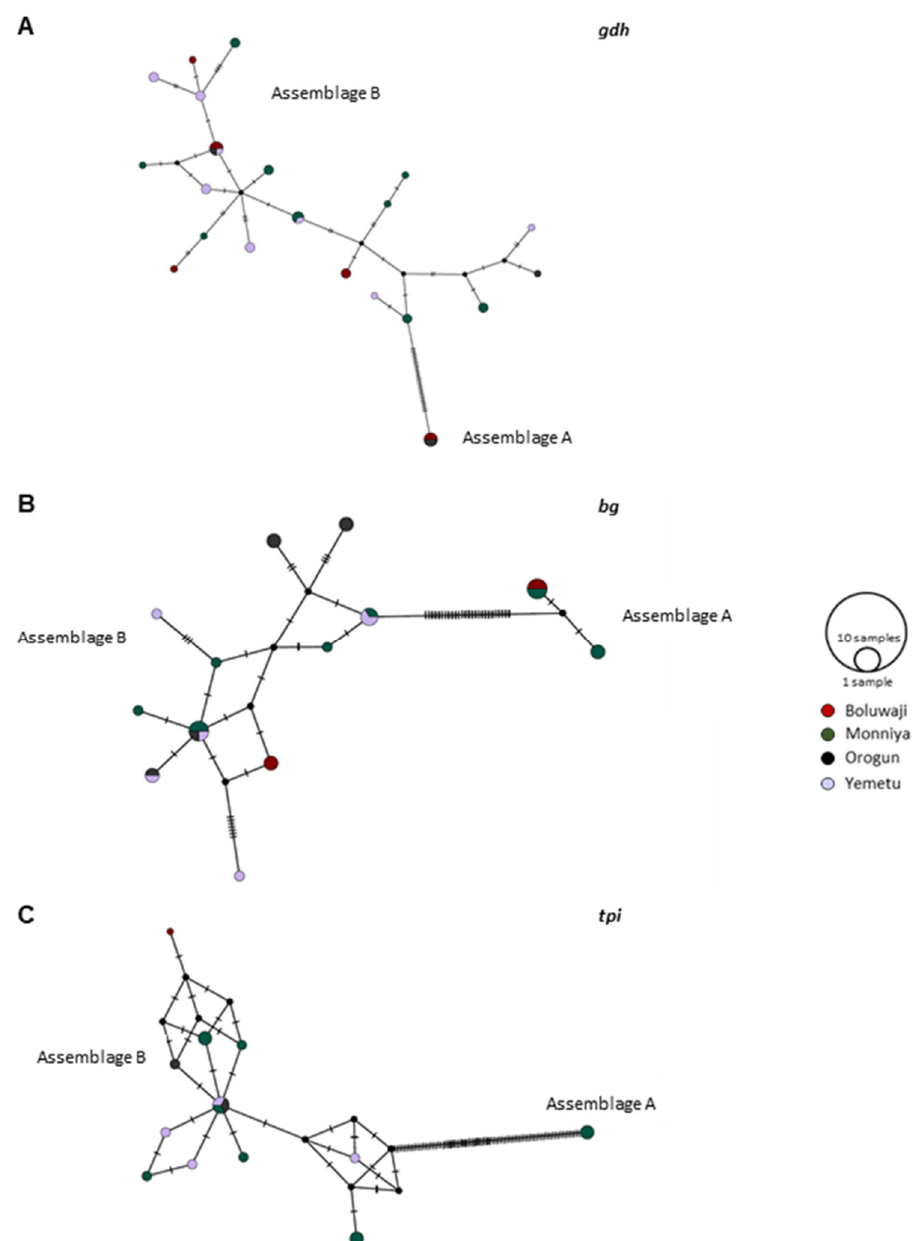
Figure 1. Median-joining haplotype networks built in PoPArt software using gdh ( A ), bg ( B ), and tpi ( C ) sequences generated in the present study. Haplotypes are represented by circles proportional to relative haplotypes abundance; different colors indicate different sampling areas. Hatch marks refer to the mutational steps between haplotypes. Black circles represent hypothetical missing haplotypes predicted.